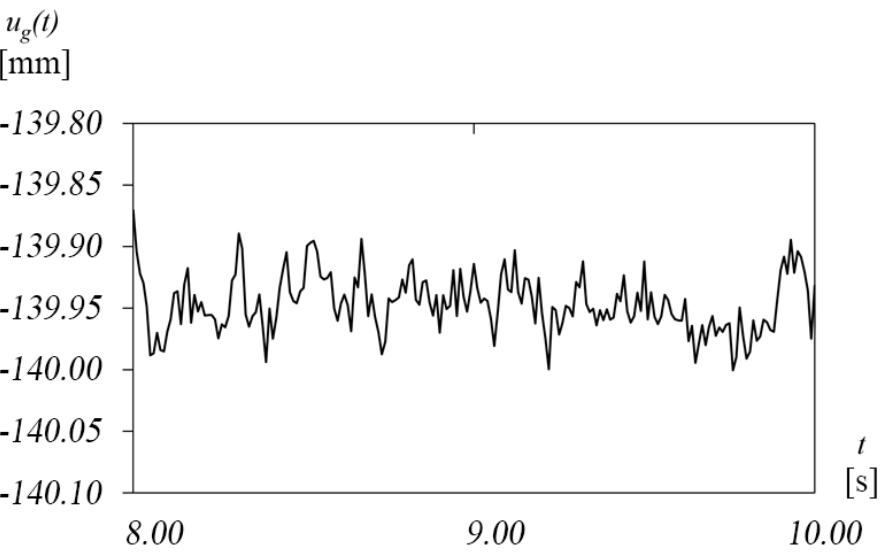
Figure 8. Measurement error in correspondence of a static marker.